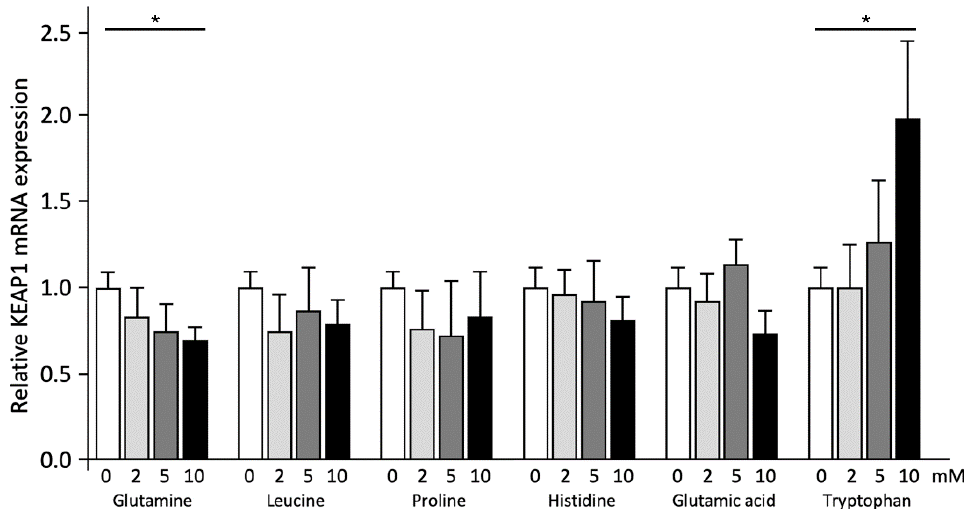
Figure 3. Amino acids have different effects on KEAP1 mRNA expression. HepG2 cells were treated with 0–10 mM of six different amino acids for 48 h and KEAP1 mRNA expression was measured by qPCR. Results are presented as means with error bars indicating standard deviations. Data were normalized against the expression observed in the control condition, which was arbitrarily set at 1. This experiment was performed twice with each condition in quadruplicate. Differences between amino acid treatment and controls were tested with linear regression analyses and were considered significant when the regression coefficients differed from zero ( p < 0.05). Significant dose-response relations ( p < 0.05) are indicated by an asterisk above a horizontal line.